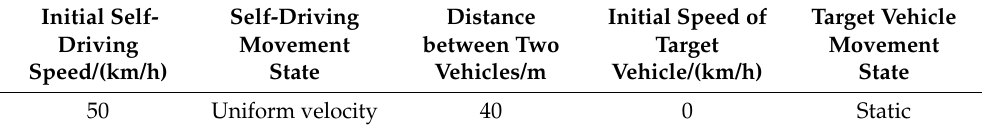
Table 5. CCRs test